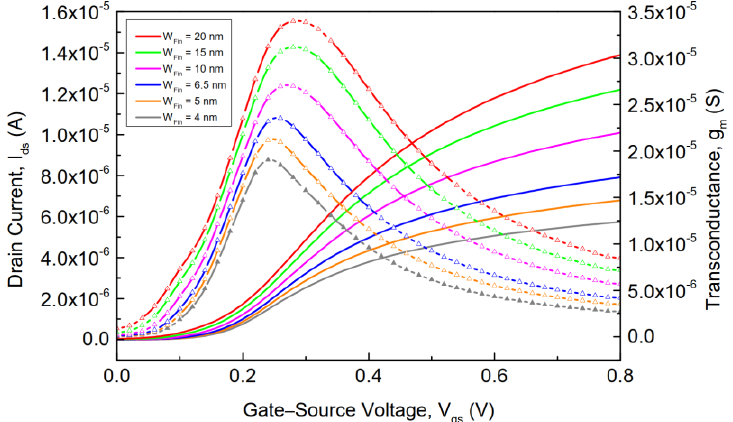
Figure 4. Behavior of the drain current (left axis) and transconductance (Triangle symbols, right axis) versus the gate – source voltage with different values of the fin width at V ds = 0.05 V. The fin height is kept fixed at 26 nm.